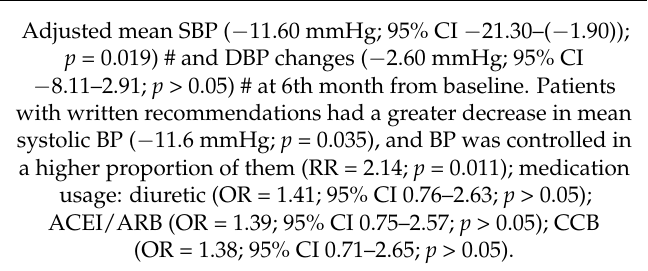
Measured Outcomes (Intervention vs. Usual